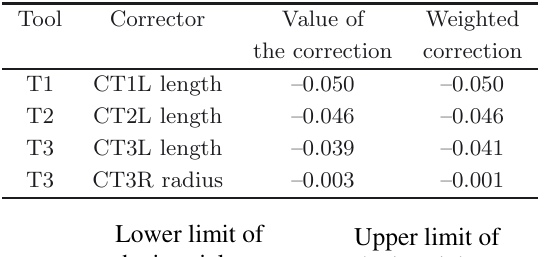
Table 5. Value of the weighted corrections.